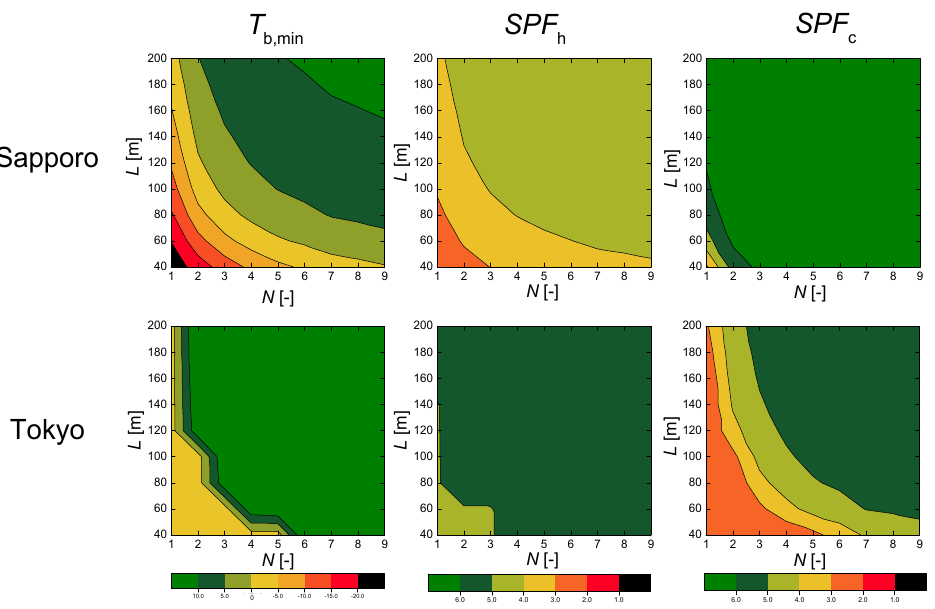
Figure 5. Simulation results of 5-year ground-source heat pump (GSHP) operation in Sapporo and Tokyo. Table 1. Two examples of simulation results in the cities of Sapporo and Tokyo in Japan. Simulation City